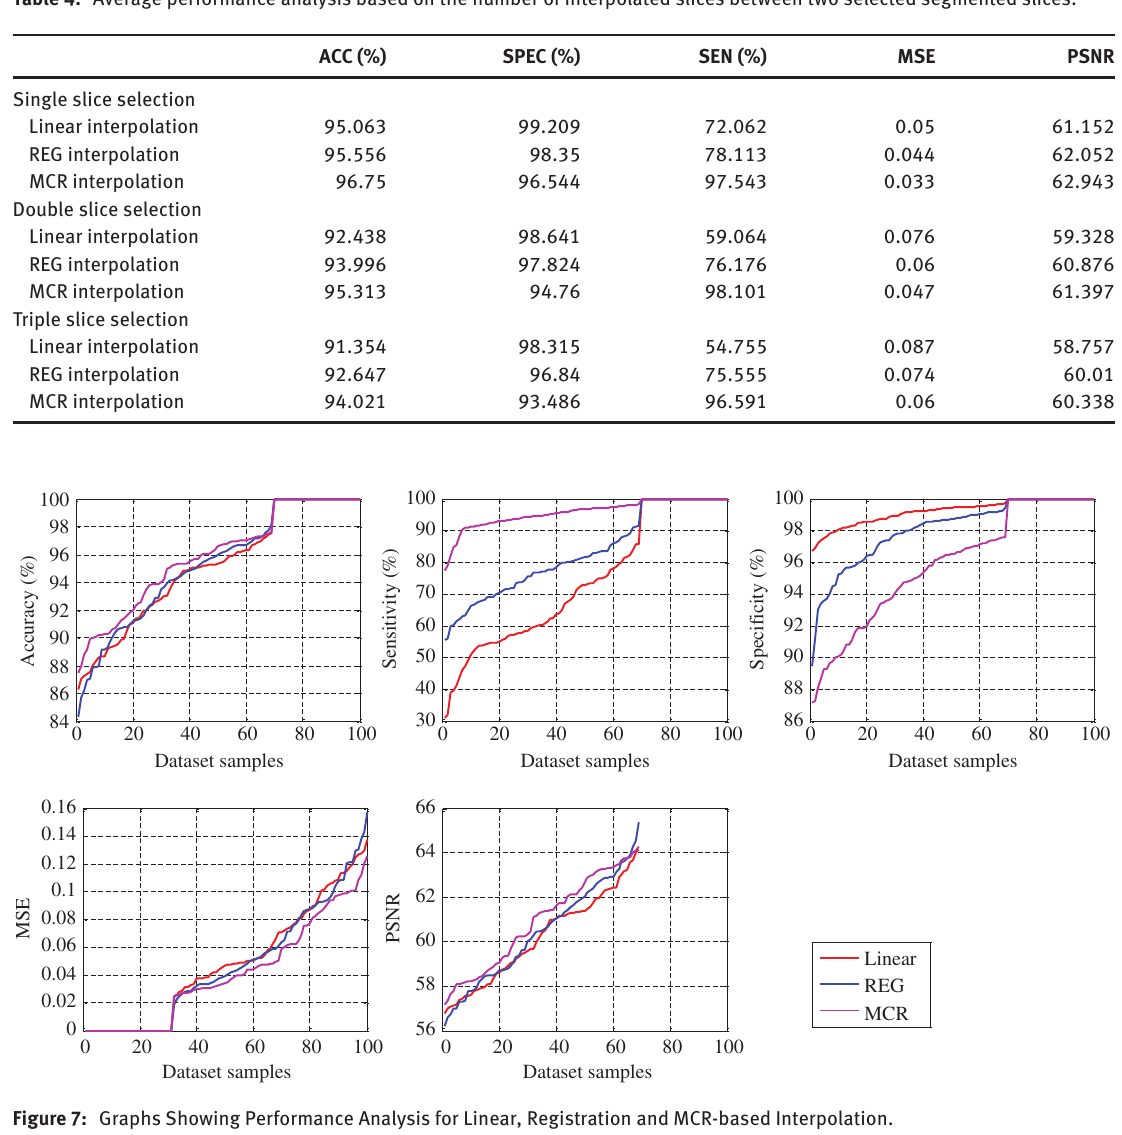
Table 4: Average performance analysis based on the number of interpolated slices between two selected segmented slices.